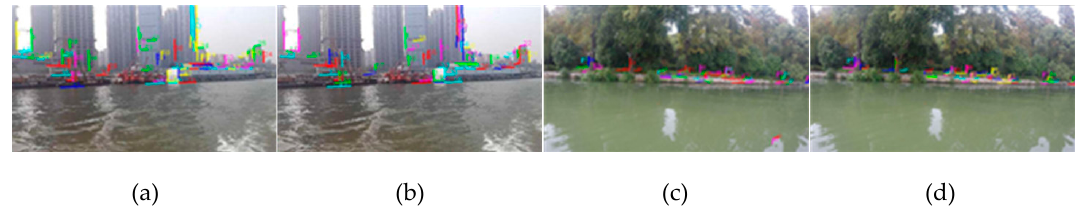
Figure 7. The results of line segment pool fine selection: ( a ) the result of line segment pool rough selection (that is Figure 4d); ( b ) the result of line segment pool fine selection on the basis of Figure 7a; ( c ) the result of line segment pool rough selection in the Yangtze River; ( d ) the result of line segment pool fine selection on the basis of Figure 7c.